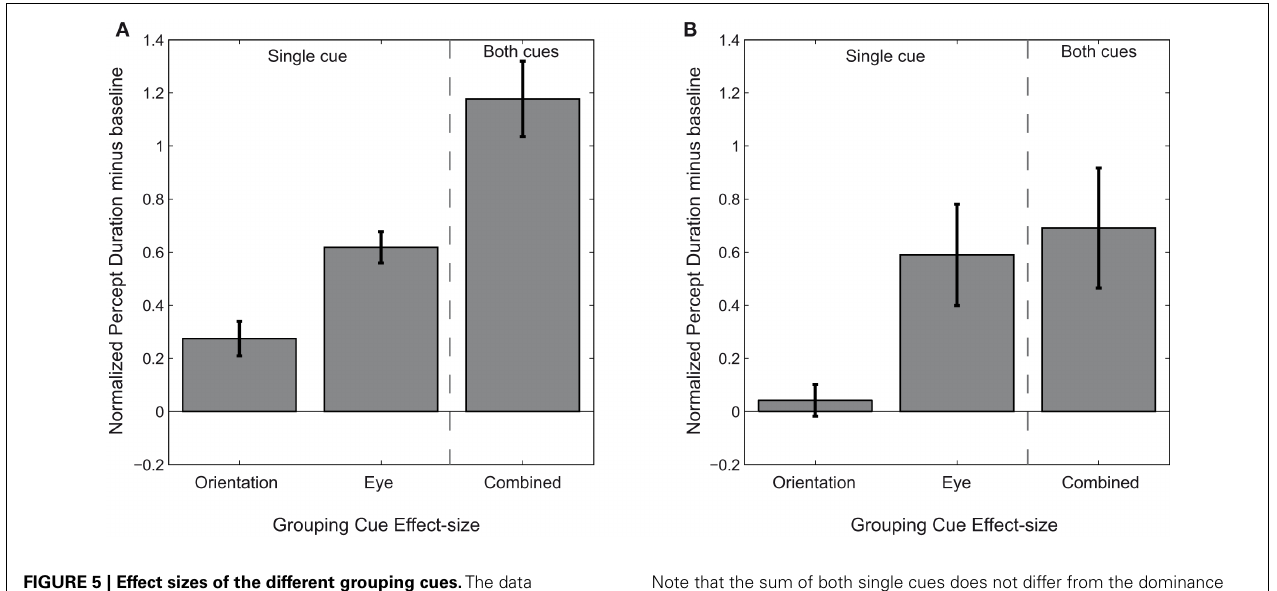
FIGURE 5 | Effect sizes of the different grouping cues. The data from Figure 4 , displayed as difference scores by subtracting the baseline dominance duration: the duration of dominance when no grouping cues are present.The difference-scores represent the added percept duration and are represented as a function of cue effect.